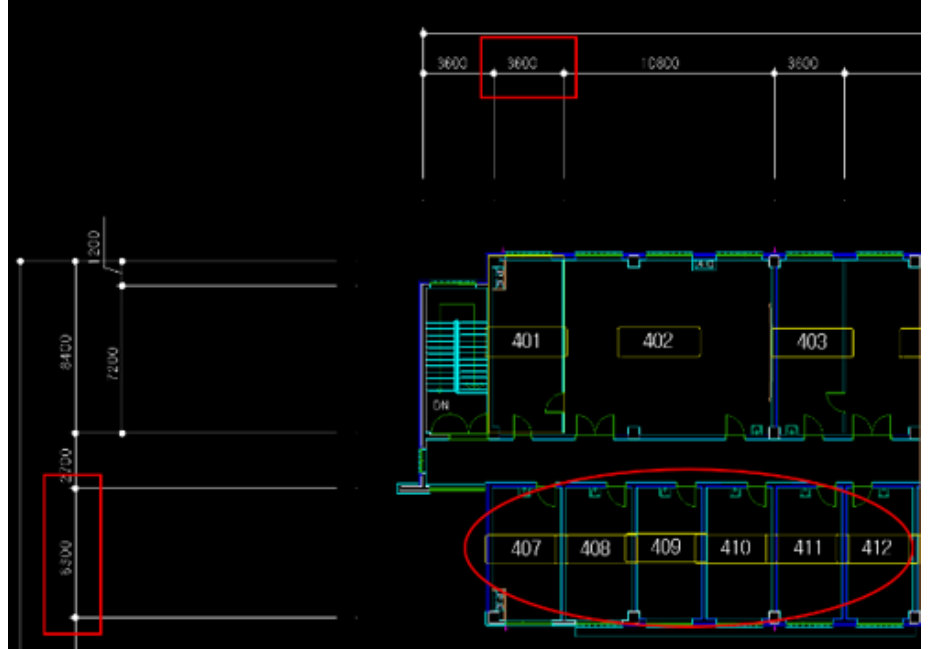
Figure 3. Floor plan of the study site (Photos courtesy of the KNU Facility Space Comprehensive Management System, which is available at http://ufis.knu.ac.kr (accessed on 10 July 2021)).